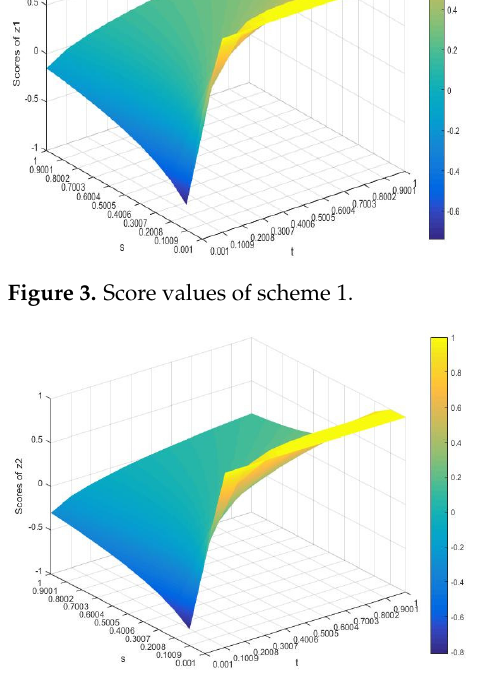
Figure 4. Score values of scheme 2.